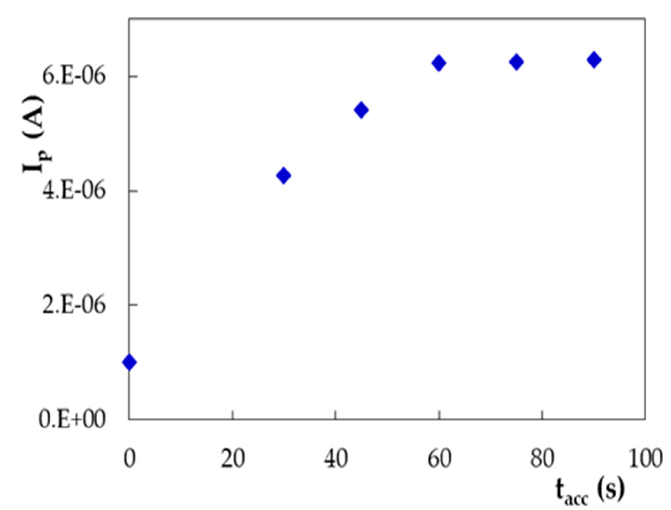
Figure 11. The influence of the accumulation time (t acc ) on DIO DPV oxidation peak current recorded on PGE_H for 1.00 × 10 − 6 mol/L DIO in 0.10 mol/L H 2 SO 4 ; E acc = 0.000 V. The effect of the accumulation potential (E acc ) on the same DIO oxidation peak was investigated by varying this parameter in the range − 0.200 to 0.200 V, while t acc was kept constant at 60 s. The DIO anodic signal did not change with the potential applied to the PGE_H during the deposition step due to the non ‐ electrochemical nature of the DIO adsorption process on the electrode surface. Thus, the influence of the concentration on the main oxidation signal of DIO from ~0.780 V was investigated between 1.00 × 10 − 7 and 1.00 × 10 − 5 mol/L DIO by adsorptive stripping differential pulse voltammetry (AdSDPV) on PGE_H carried out applying the optimized deposition parameters, i.e., E acc 0.000 V and t acc of 60 s (Figure 12). The accumulation step was done under stirring conditions and the recordings were performed in still solution, after an equilibration time of 5 s. The obtained peak currents varied linearly with the analyte concentration between 1.00 × 10 − 7 and 2.50 × 10 − 6 mol/L DIO (Figure 12 inset). At DIO concentrations higher than 2.50 × 10 − 6 mol/L, the calibration curve was flattened due to the saturation of the electrode surface with adsorbed DIO molecules. Figure 12. Adsorptive stripping differential pulse voltammograms recorded on PGE_H for differ ‐ ent concentrations of DIO in 0.10 mol/L H 2 SO 4 ; E acc = 0.000 V and t acc = 60 s. The inset shows the corresponding calibration curve.